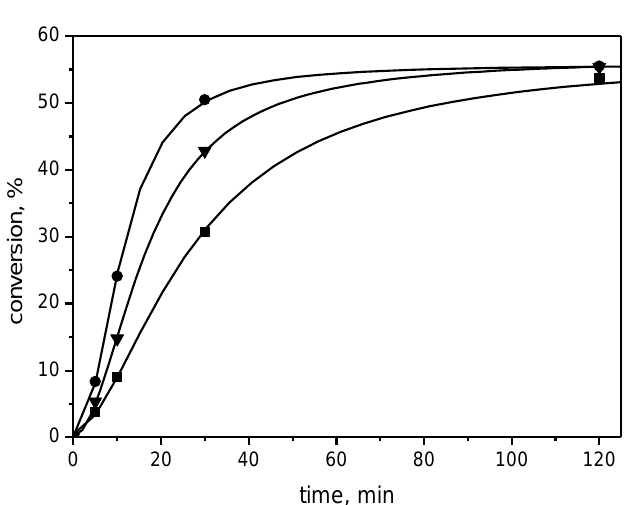
Figure 6. E ff ect of catalyst pore size on conversion in the metathesis of methyl oleate. Toluene, 60 ◦ C, Ru / MeOl = 1:250, c 0 MeOl = 0.15 mol / L, catalysts 4.6 / SBA-15 ( d = 6.9 nm) ( (cid:72) ), 4.6 / SBA-15LP ( d = 11.1 nm) ( ), 4.6 / MCM-41(4.0 nm) ( (cid:4) ). Taken from Reference [43] © American Chemical Society (ACS). Reproduced with the permission of ACS Publications.